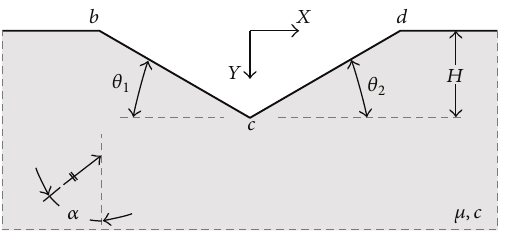
Figure 3: Symmetrical V-shaped canyon representable by 3 wedges with apex at points 𝑏 , 𝑐 , and 𝑑 , respectively. Each wedge contributes with a source of diffraction acting upon the main plane incident front (first-order diffraction) or upon the cylindrical waves gener- ated at adjacent wedges (higher-order diffraction).